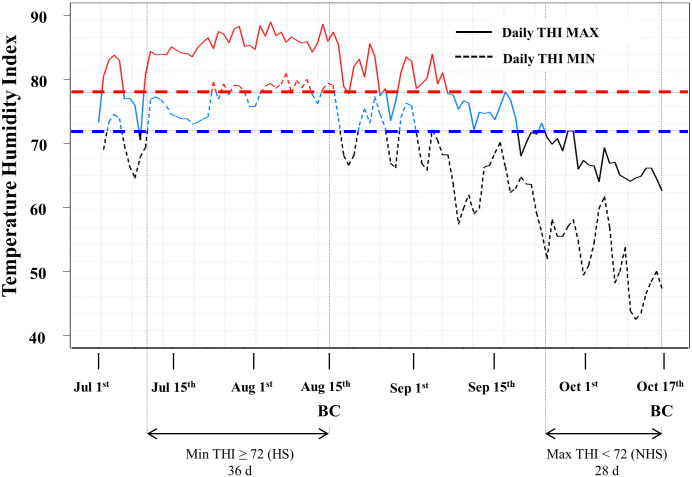
Temperature-humidity index (THI) measured on dairy barn.The straight line represents daily THI maximum and the dotted line represents daily THI minimum. THI over 78 is marked in red (moderate to severe stress), and 72–78 in blue (mild to moderate stress), and less than 72 in black (non-stress). Vertical dotted line represents THI on the day of sampling. BC, Blood collection; HS, Heat stress condition; NHS, Non-heat stress condition.